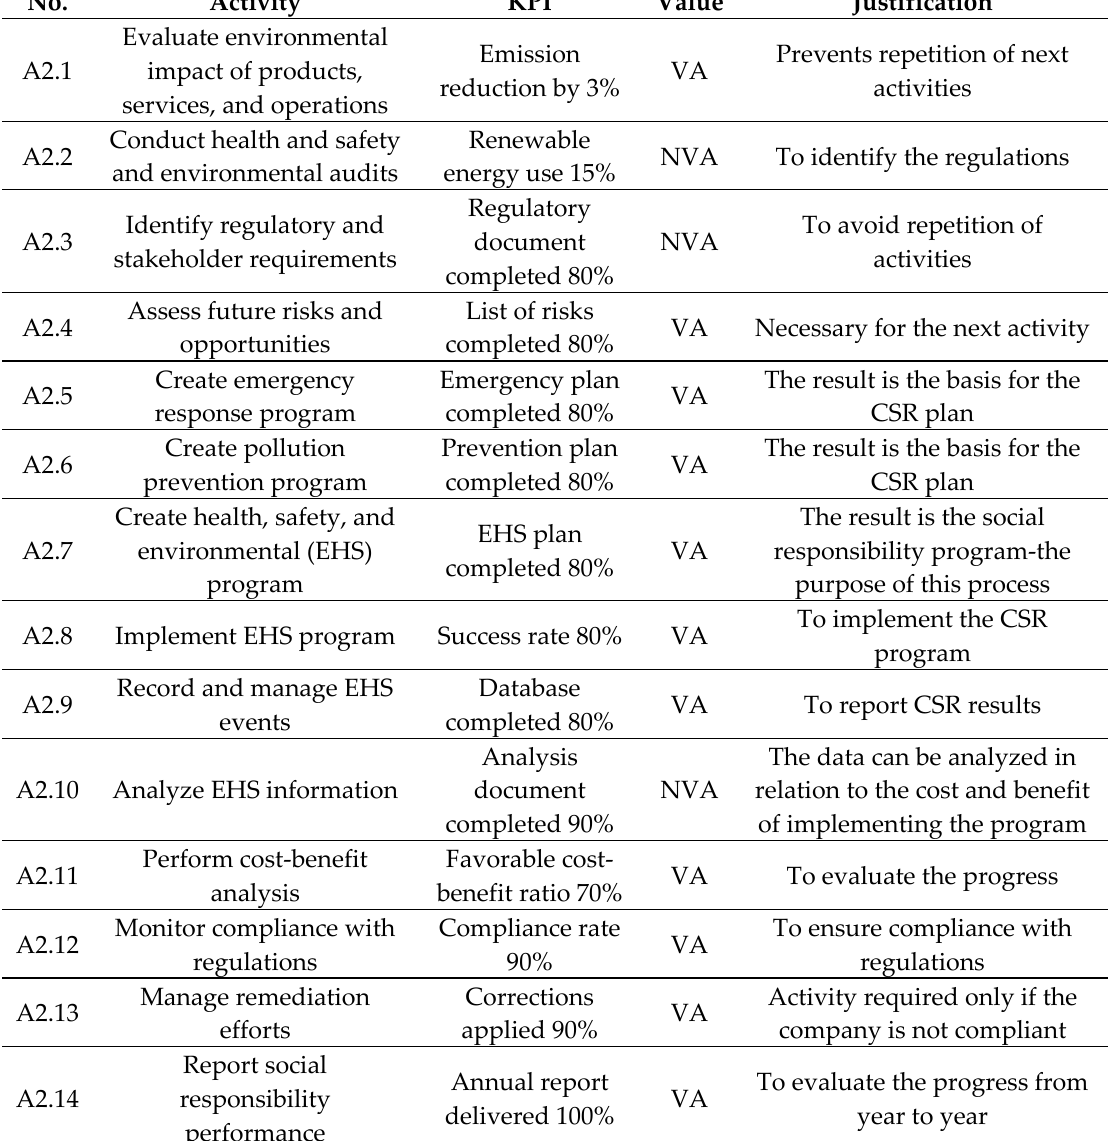
Table 3. P2 process-initial